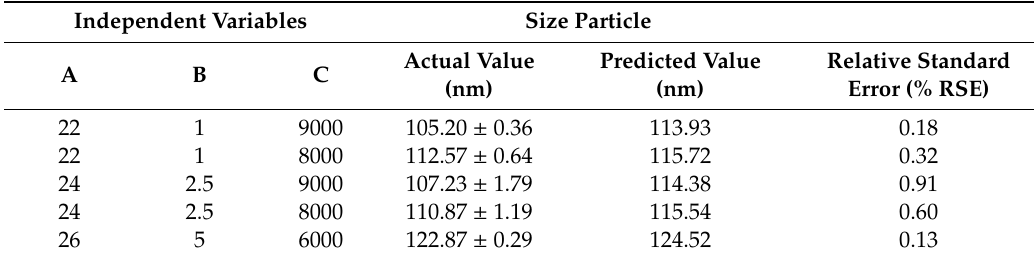
Table 5. Validation set of the KMO nanoemulsion formulation.